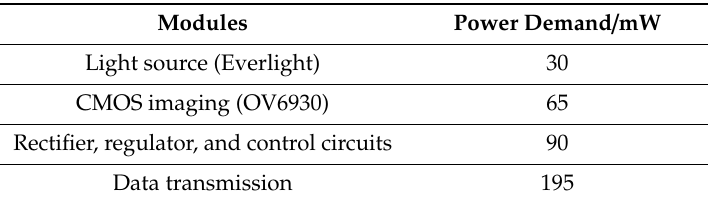
Table 1. Power demands for each module of the